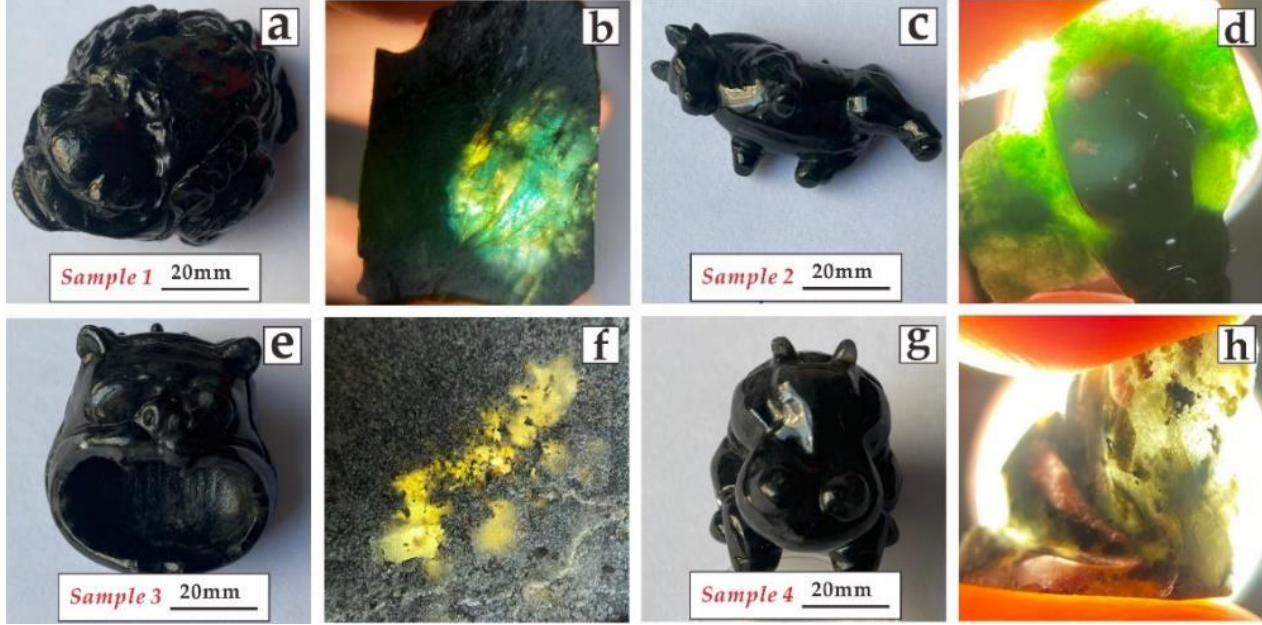
Figure 1. Photograph and corresponding light transmission images of the four samples:( a ) Sample 1 shows worst polishing status; ( b ) aquamarine blue and yellow are both showed in Sample 1; ( c ) Sample 2 shows the homogenous appearance; ( d ) homogenous color distribution of yellow-green to green in Sample 2; ( e ) fine engraving of Sample 3; ( f ) unknown crumby or punctate black minerals in Sample 3; ( g ) white “snowflake floc” are widespread on Sample 4; ( h ) unknown black minerals but chiefly as crumby appearance present in Sample 4.